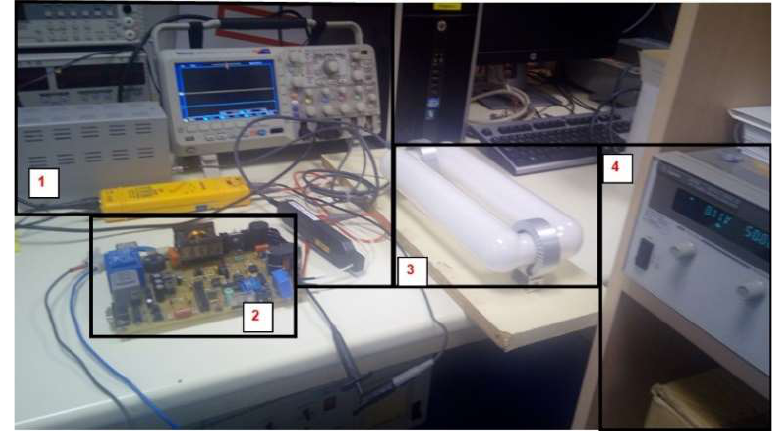
Figure 12. Measurement setup: ( 1 ) oscilloscope and probes, ( 2 ) electronic ballast prototype, ( 3 ) EFL lamp and ( 4 ) AC power source.